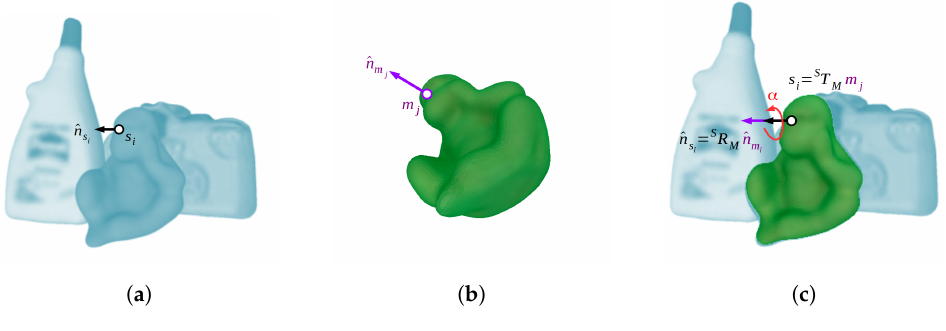
Figure 3. Representation of the local coordinate (LC) system used by the point pair features method; ( a ) scene oriented point; ( b ) corresponding object model oriented point; ( c ) alignment of the model with the scene by using the two oriented points and the α